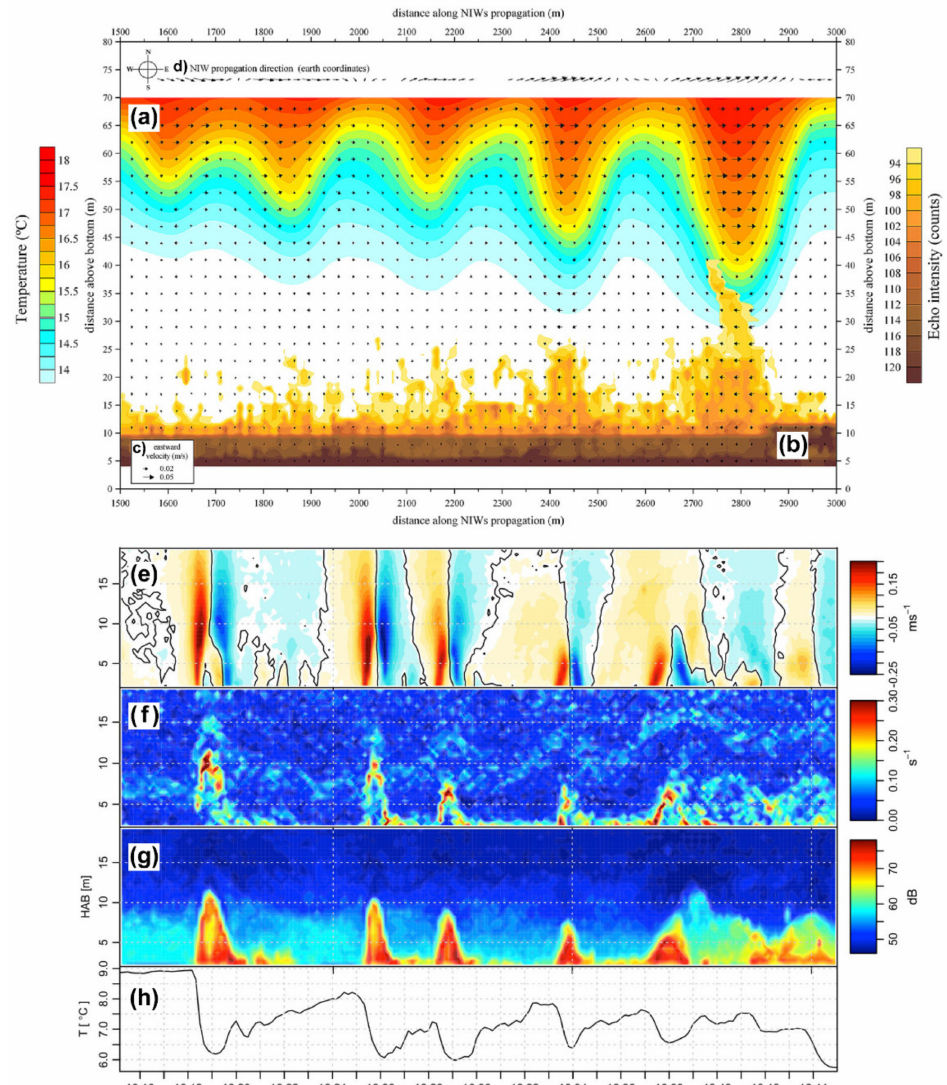
Figure 11. Sediment resuspension due to NLIWs propagating. Comparison between ( a ) temperature profile, ( b ) echo intensity, ( c ) eastward velocity, and ( d ) NLIW propagation direction during an NLIW train propagation. A 30min segment of an NLIW shoaling event, comparison between ( e ) vertical velocity, ( f ) vertical shear of the horizontal current, ( g ) acoustic backscatter, and ( h ) bottom temperature. The black line in ( e ) shows zero. Panels ( a – d ) adapted from Quaresma et al. [84], with permission from Elsevier, and panels ( e – h ) adapted from Richards et al. [90], with permission from